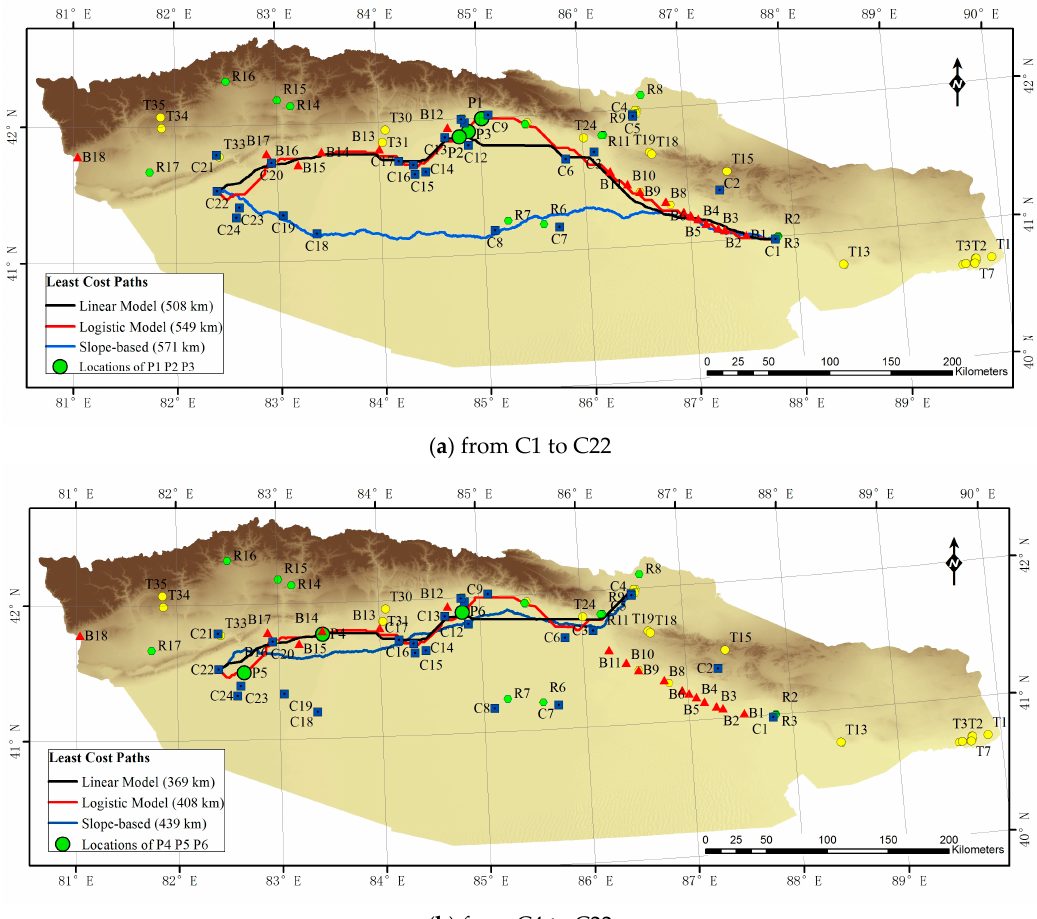
Figure 7. Least cost paths based on: linear model, logistic model, and slope model in the direction of ( a ) from C1 to C22 and the direction of ( b ) from C4 to C22 (P1, P5: the locations of largest cumulative deviation between the paths of logistic model and slope model; P2, P4: the locations of largest cumulative deviation between the paths of linear model and slope model; P3, P6: the locations of largest cumulative deviation between the paths of linear model and logistic model).